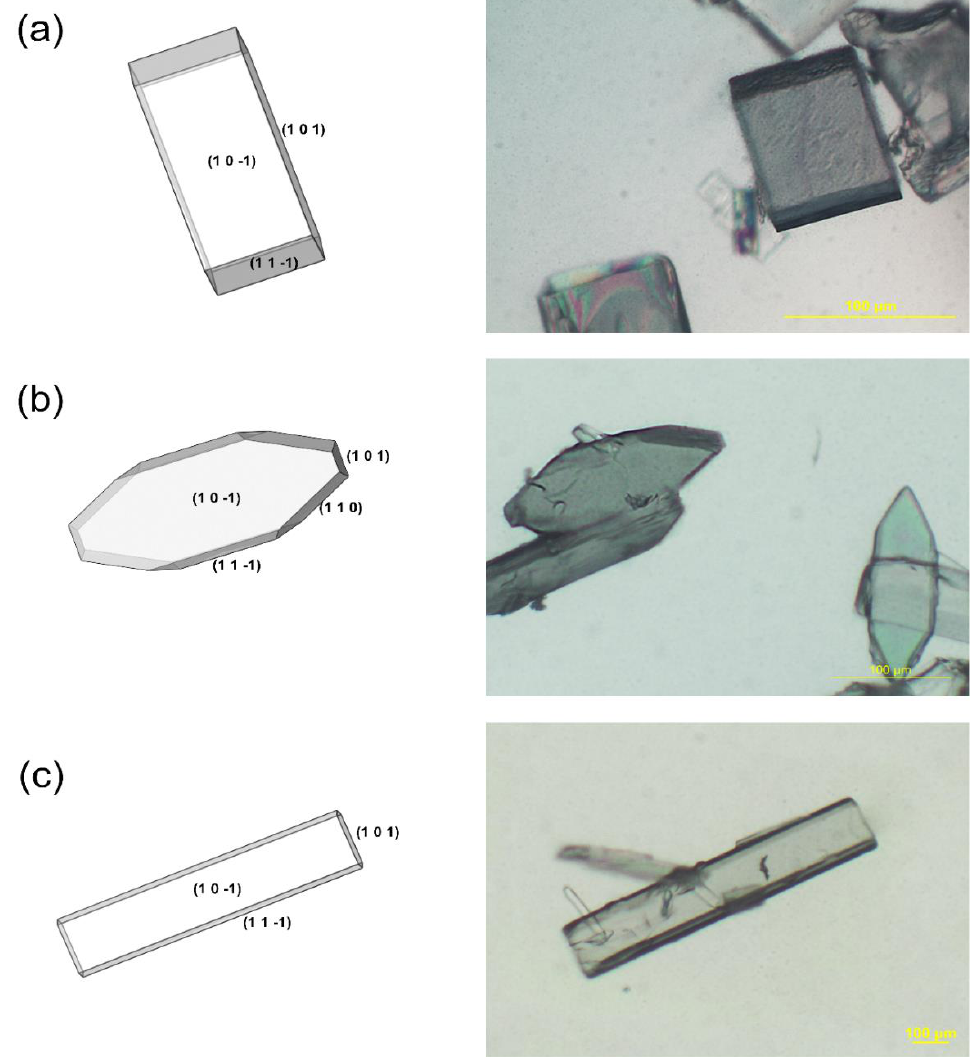
Figure 4. The modified morphology with the modified attachment energy (MAE) model (on the left) and the corresponding experimental crystal habits (on the right) of catechol in ( a ) isopropanol (IPA), ( b ) methyl acetate (MAC), and ( c ) ethyl acetate (EAC).